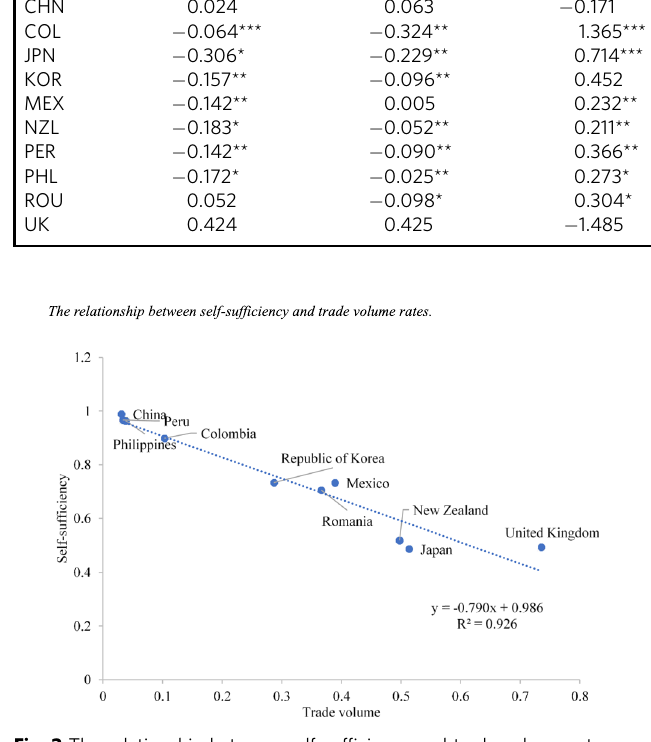
Fig. 3 The relationship between self-suf fi ciency and trade volume rates.